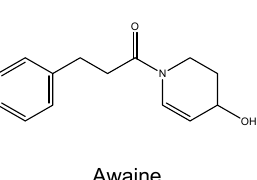
Figure 5. Chemical structures of pipermethystine (PM), 3 α ,4 α -epoxy-5 β -pipermethystine and awaine.